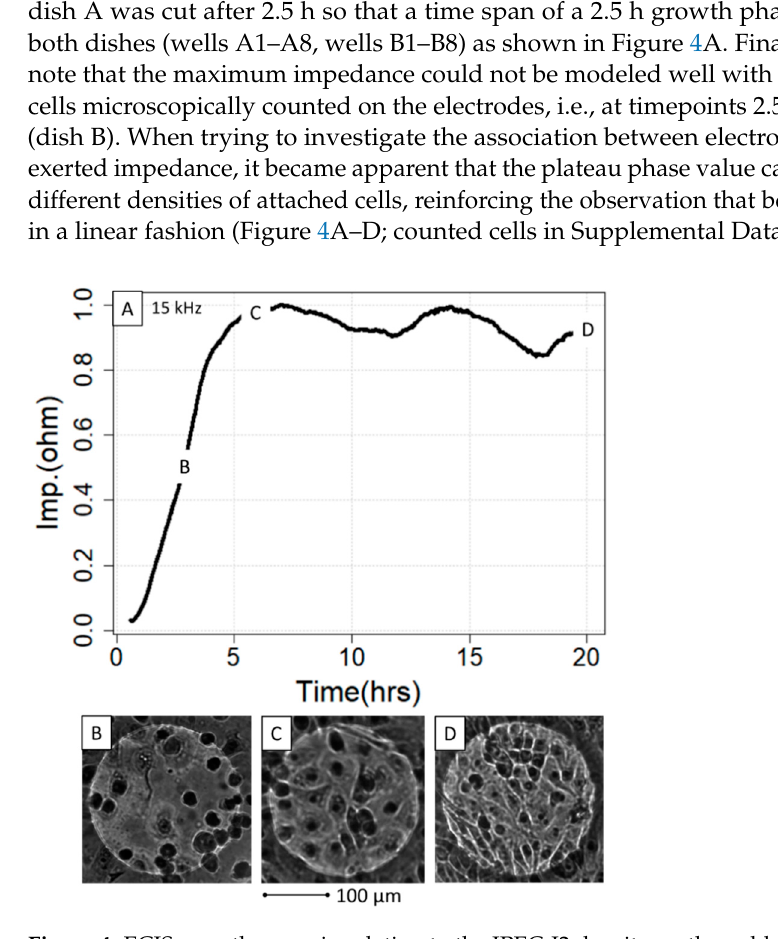
Figure 4. ECIS growth curve in relation to the IPEC-J2 density on the gold electrodes. The growth curve ( A ) was microscopically investigated at three different timepoints, 2.5 h ( B ), 6 h ( C ) and 22 h ( D ), with regard to cell density and interaction. Note that although ( C , D ) are in the plateau phase, the micrographs indicate significantly different cell density without impacting the impedance. hrs = hours, Imp = impedance.